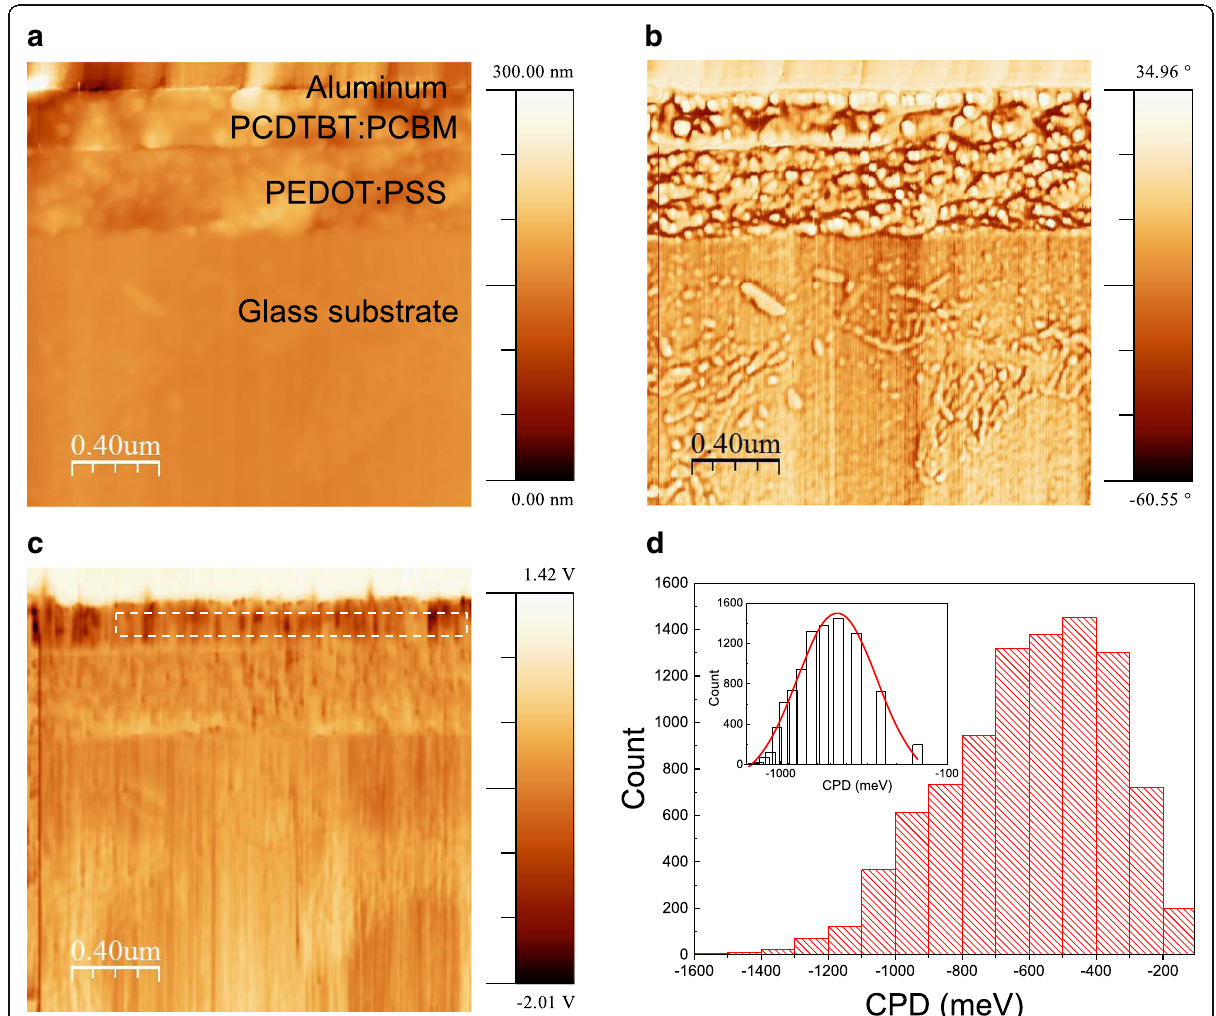
Fig. 4 Simultaneously obtained wide view of cross-sectional images of a topography, b phase, c CPD, and d probability distribution of CPD values in dotted box of field-free region in photoactive area and log-normal distribution fit